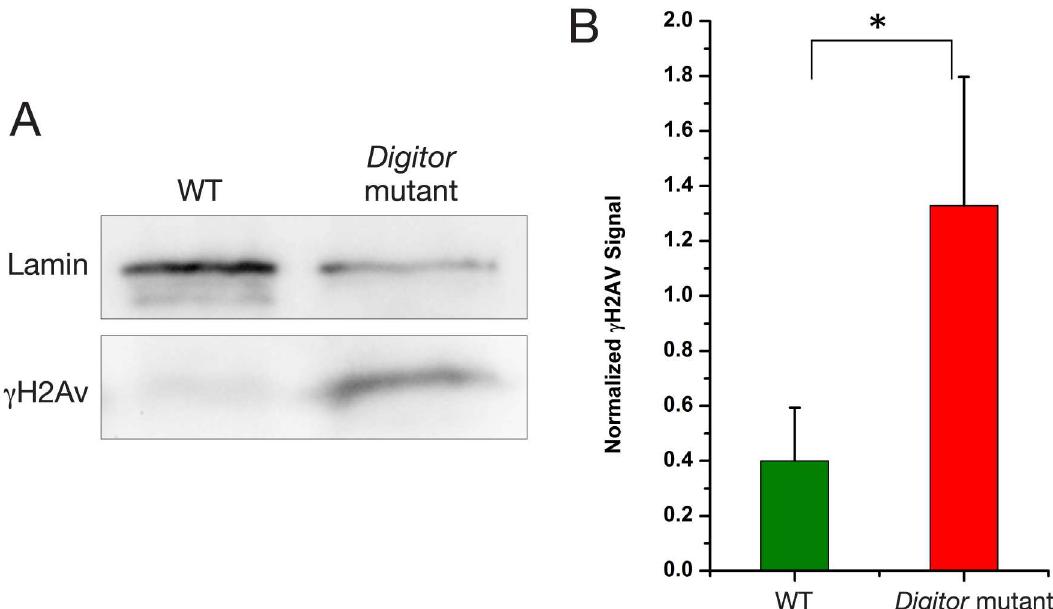
statisticallysignificant (Student’s two-tailedt-test, P <